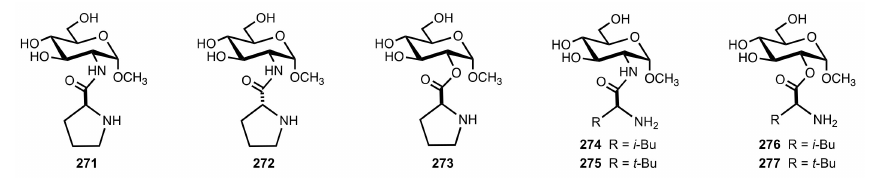
Figure 23. Sugar-proline and sugar-leucine derivatives prepared by Machinami and co-workers. The amides and esters 271–277 were used to catalyse exclusively the aldol reaction of p -nitrobenzaldehyde with acetone (reagent and solvent) in the presence of water (55% v / v ) (Scheme 76). The aldol was obtained in good yield (HPLC analysis) but low enantiomeric excess; however, it was found that the organocatalysts 271 , 274 , 275 bearing an L -amino acid moiety led to the ( R )-configured adduct while the D -amino acid derivative 272 gave the ( S )-enantiomer. When the amount of water was decreased from 55 to 5%, significant increase in enantioselectivity was observed; however, the adducts were formed at a much lower